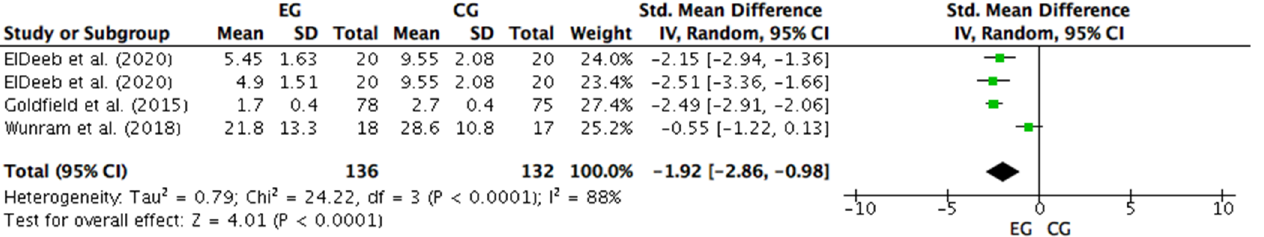
Figure 8. Forest plot comparing the effects of conventional and vibration platform strength training on depression levels. EG: experimental group; CG: control group; SD: standard deviations.